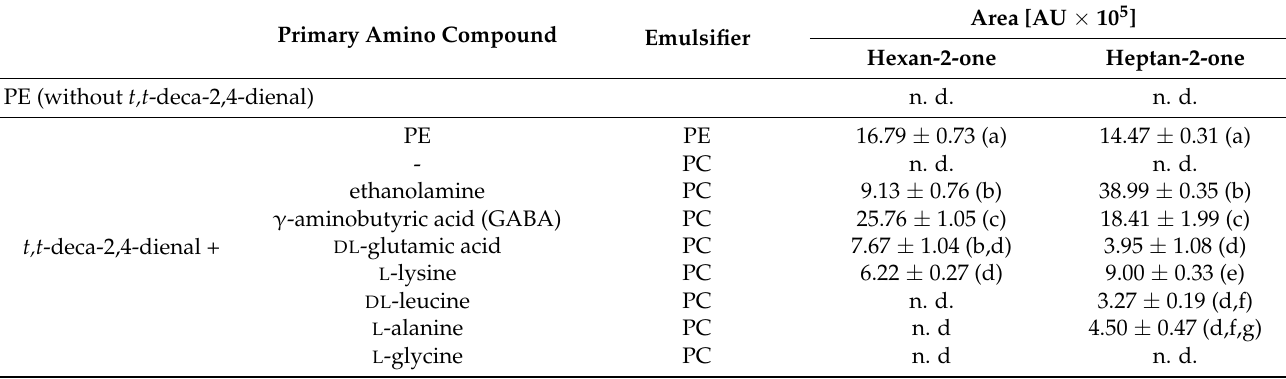
L -alanine PC n. d 4.50 ± 0.47 (d,f,g) L -glycine PC n. d n.